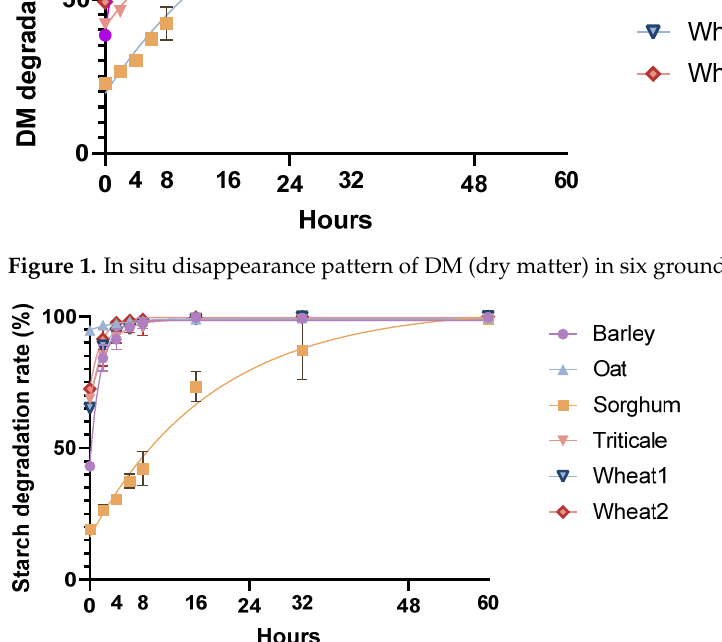
Figure 2. In situ disappearance pattern of starch in six ground grains.